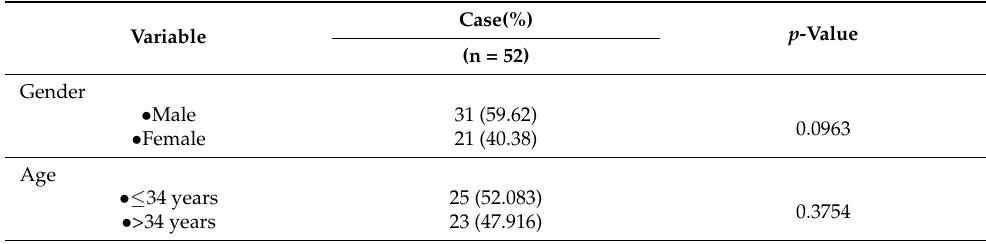
Table 1. A 2A R gene expression was not correlated with clinical parameters in Moroccan